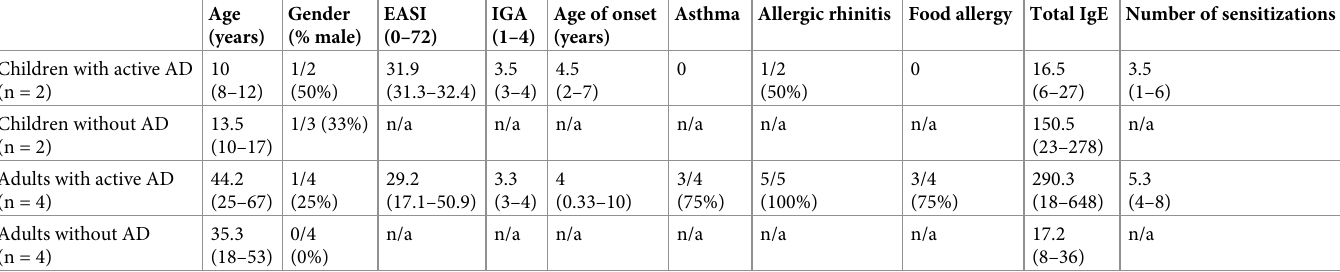
Table 2. Demographics of six age-matched AD case and control